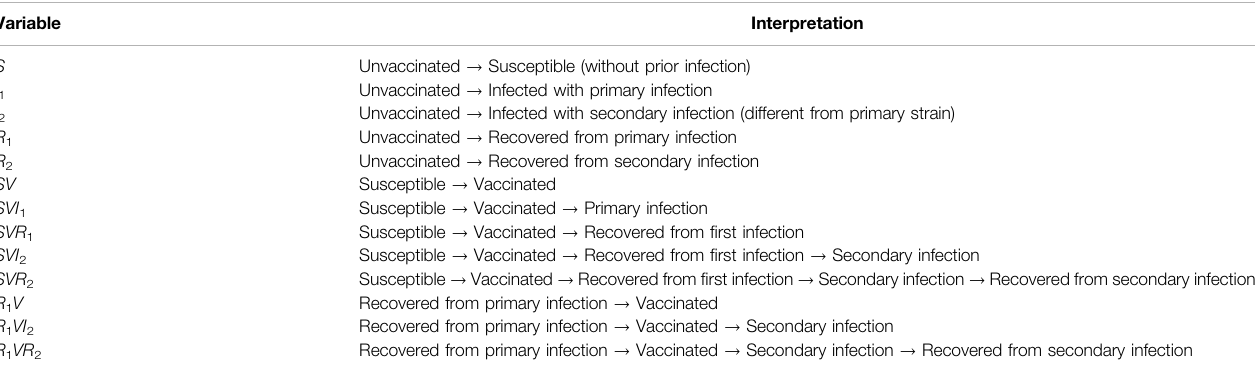
TABLE 2 | Compartments of the